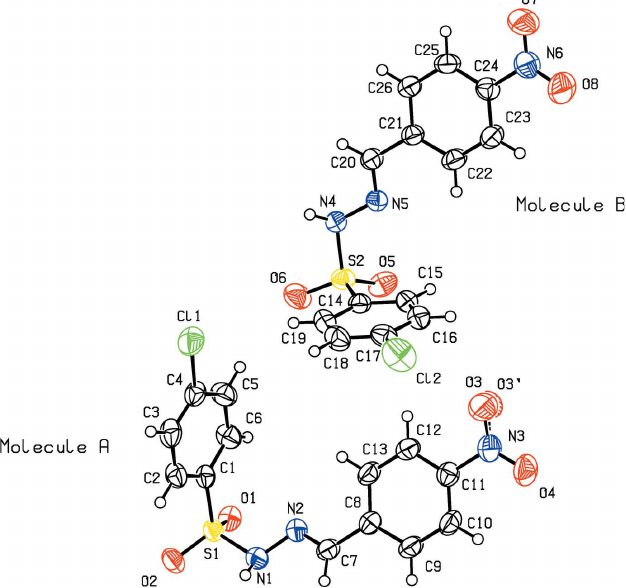
Figure 2 Molecular structure of (II), with the atom labelling and displacement ellipsoids drawn at the 50% probability level.